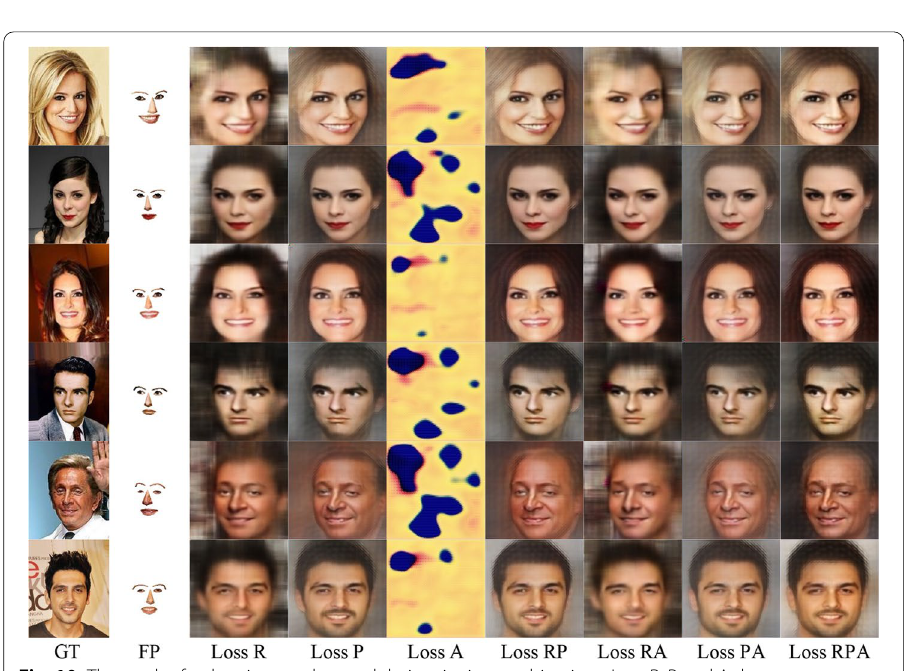
Fig. 10 The result of only using one loss and their pairwise combinations. Loss R, P, and A denote reconstruction loss, perceptual loss and adversarial loss, respectively, and Loss RP is the combination of reconstruction loss and perceptual loss. In this model, using adversarial loss alone does not make any